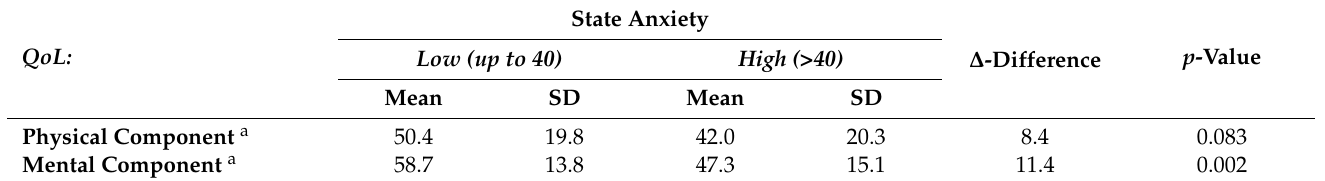
Table 3 compared the mean scores of the two main components of the SF-36 with regard to anxiety. Patients with a high state anxiety score had significantly lower mean Mental Component scores compared to patients with low state anxiety (47.3 versus 58.7, p = 0.002), and borderline non-significant Physical Component scores (42.0 versus 50.4, p > 0.05). Table 3. Comparison of the two main SF-36 QoL scale components of the 83 study participants for low and high state anxiety.